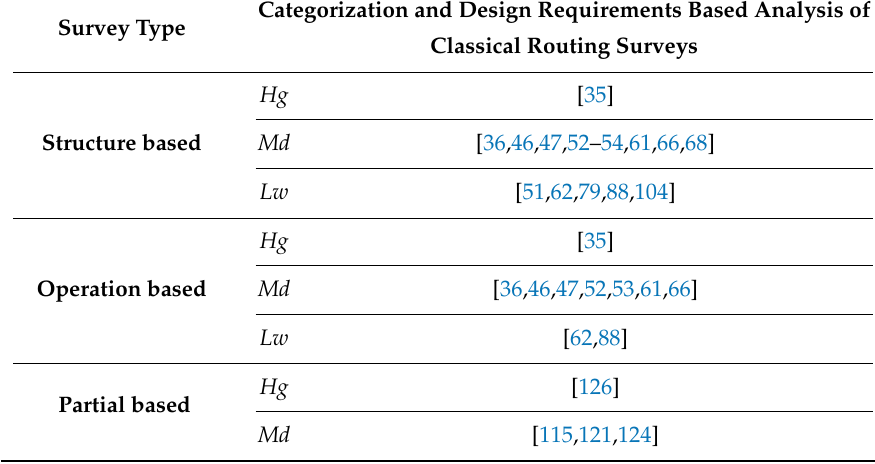
Table 5. Design analysis of classical routing surveys in